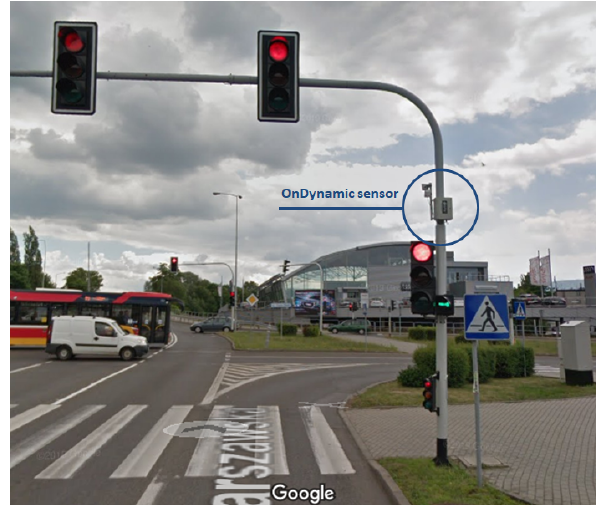
Figure 6: Example of OnDynamic device implemented in the road infrastructure [source: Google